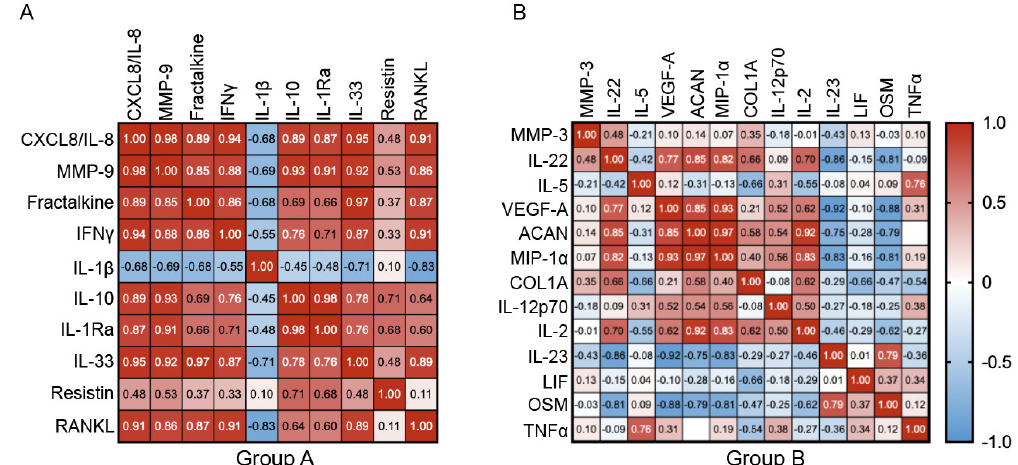
Figure 5. Pearson’s correlation heatmaps of the two identified protein groups after Multivariate Factor Analysis. Cytokines belonging to group A (left panel), presented strong to very strong correlation ( p < 0.05), with the exception of resistin ( A ). Generally, group B (right panel) presented weaker correlations; however, the cluster including VEGF-A, ACAN, CCL3/MIP-1α, IL-22, IL-2, IL-23 and OSM were highly and significantly correlated ( p < 0.05) ( B ). Color code represents positive or negative linear relationship between proteins, red and blue, respectively. White values indicate no shared trend between the